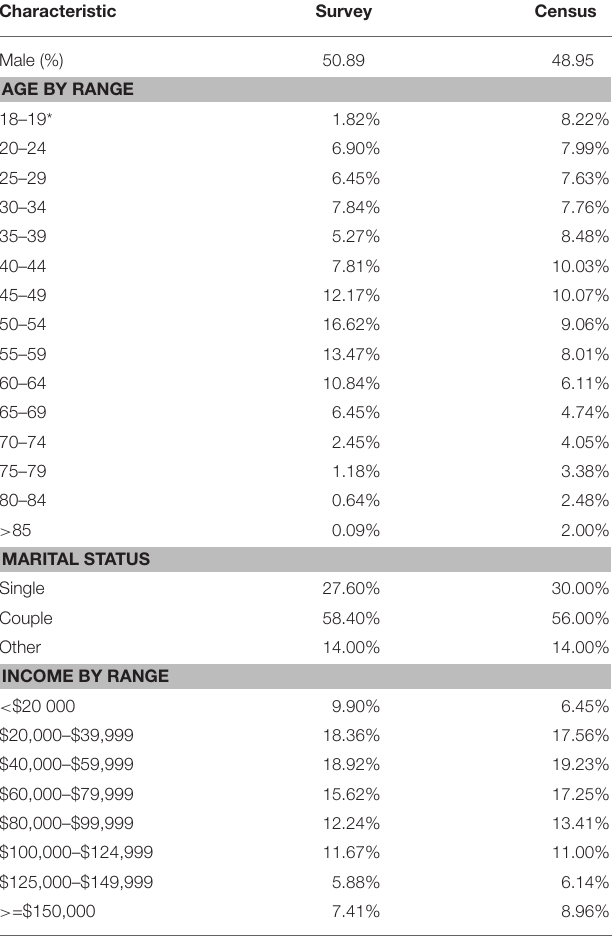
TABLE 2 | Comparison of survey demographics with the 2006 Canadian